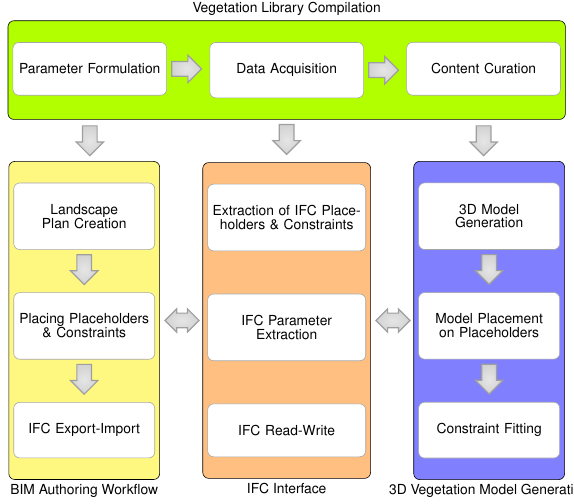
Figure 1. Proposed methodology workflow for IFC-centric vegetation modelling for